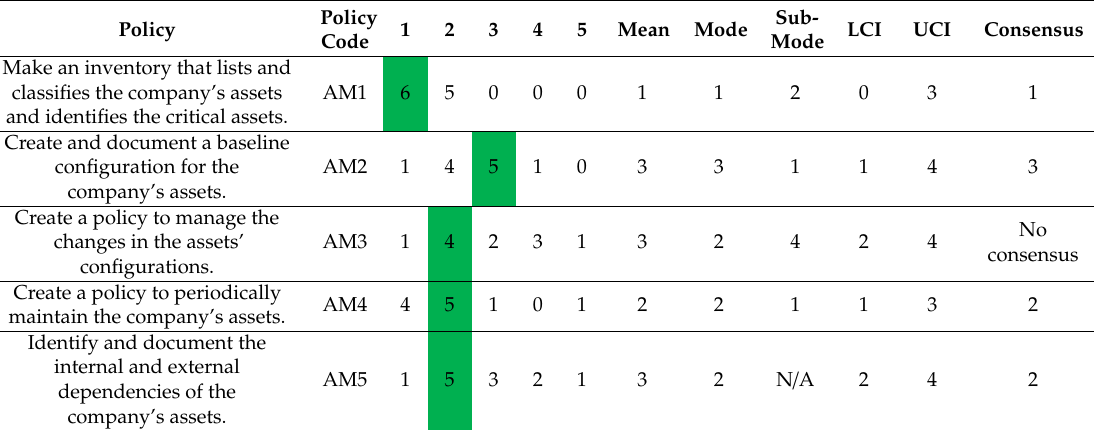
Table 8. Asset management policies’ starting